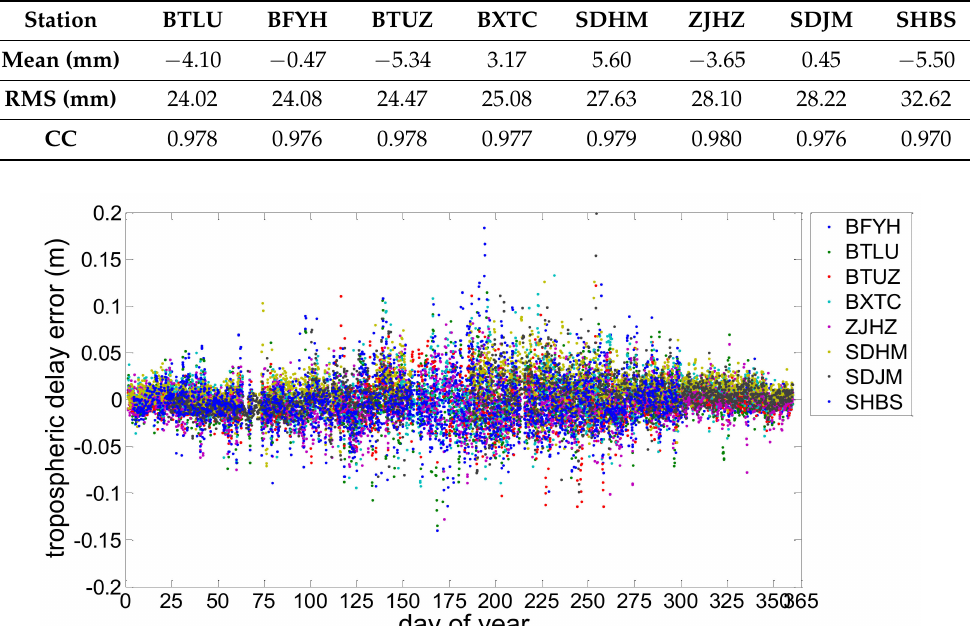
Figure 5. Time series of NWP ZTD (blue line) and GAMIT ZTD (red line) at station SHBS. Table 1. Mean residual, RMS and the correlation coefficients (CC) of NWP ZTD.